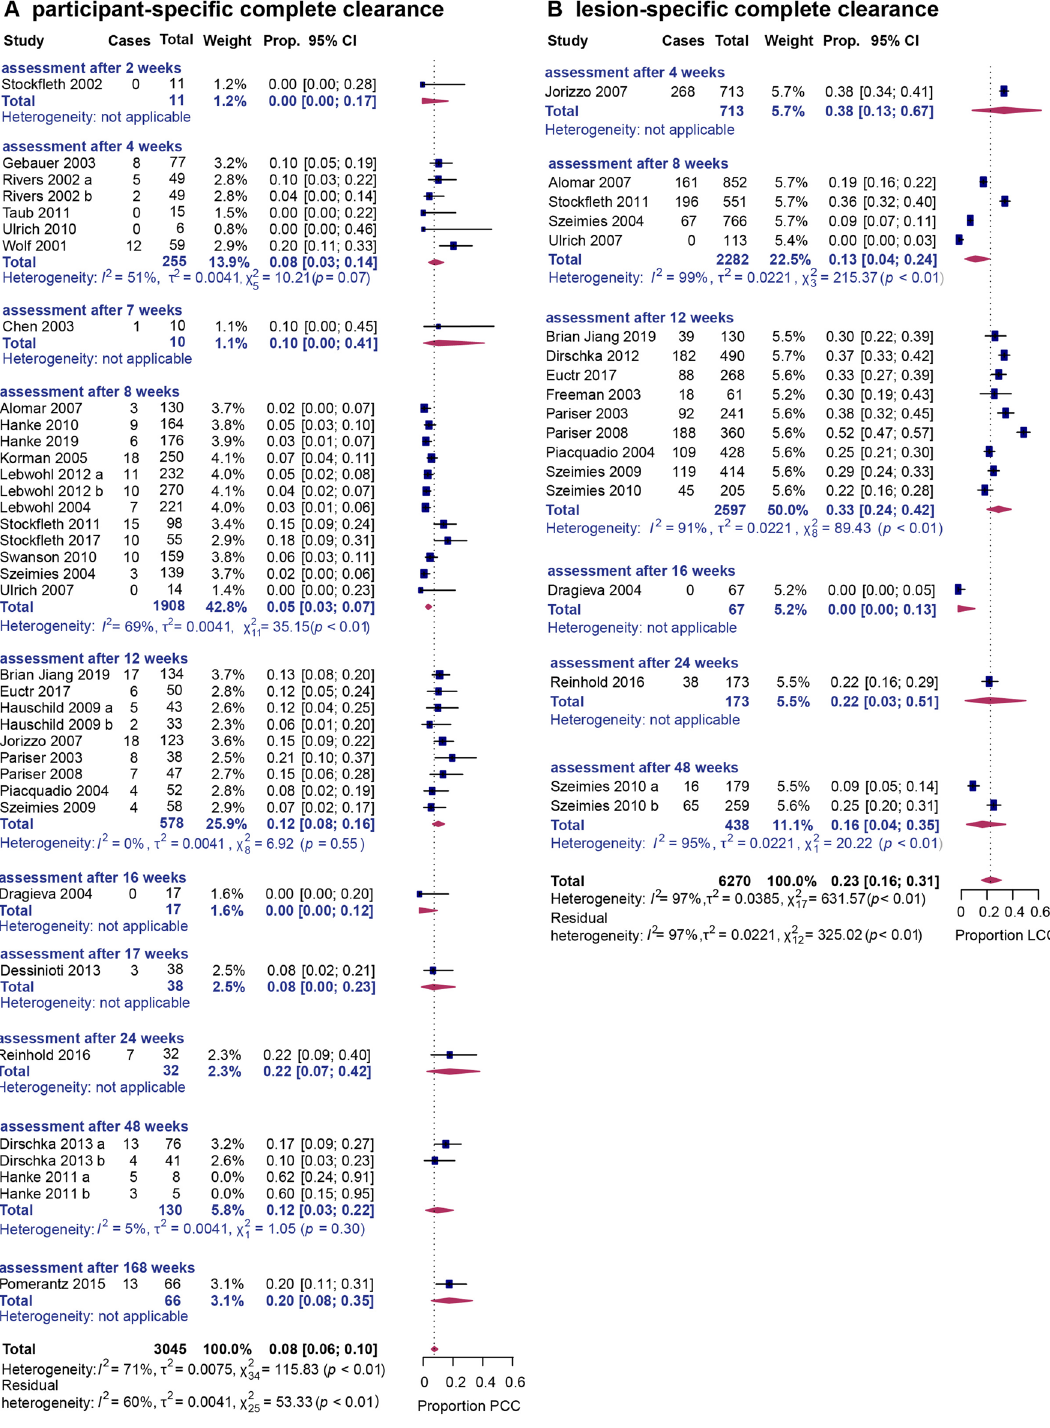
Figure 2. ( A ) Forest plot examining the pooled proportion of the outcome participant-specific complete clearance (PCC) rate for the different time points. Outliers have been excluded. ( B ) Forest plot examining the pooled proportion of the outcome lesion-specific complete clearance (LCC) rate for the different time points. In all cases, forest plots examining single-armed trials are shown. Random-effects analysis was used. The diamond represents the estimate from the studies. The width of the line extending from each diamond represents the 95% confidence interval (CI). Prop.: